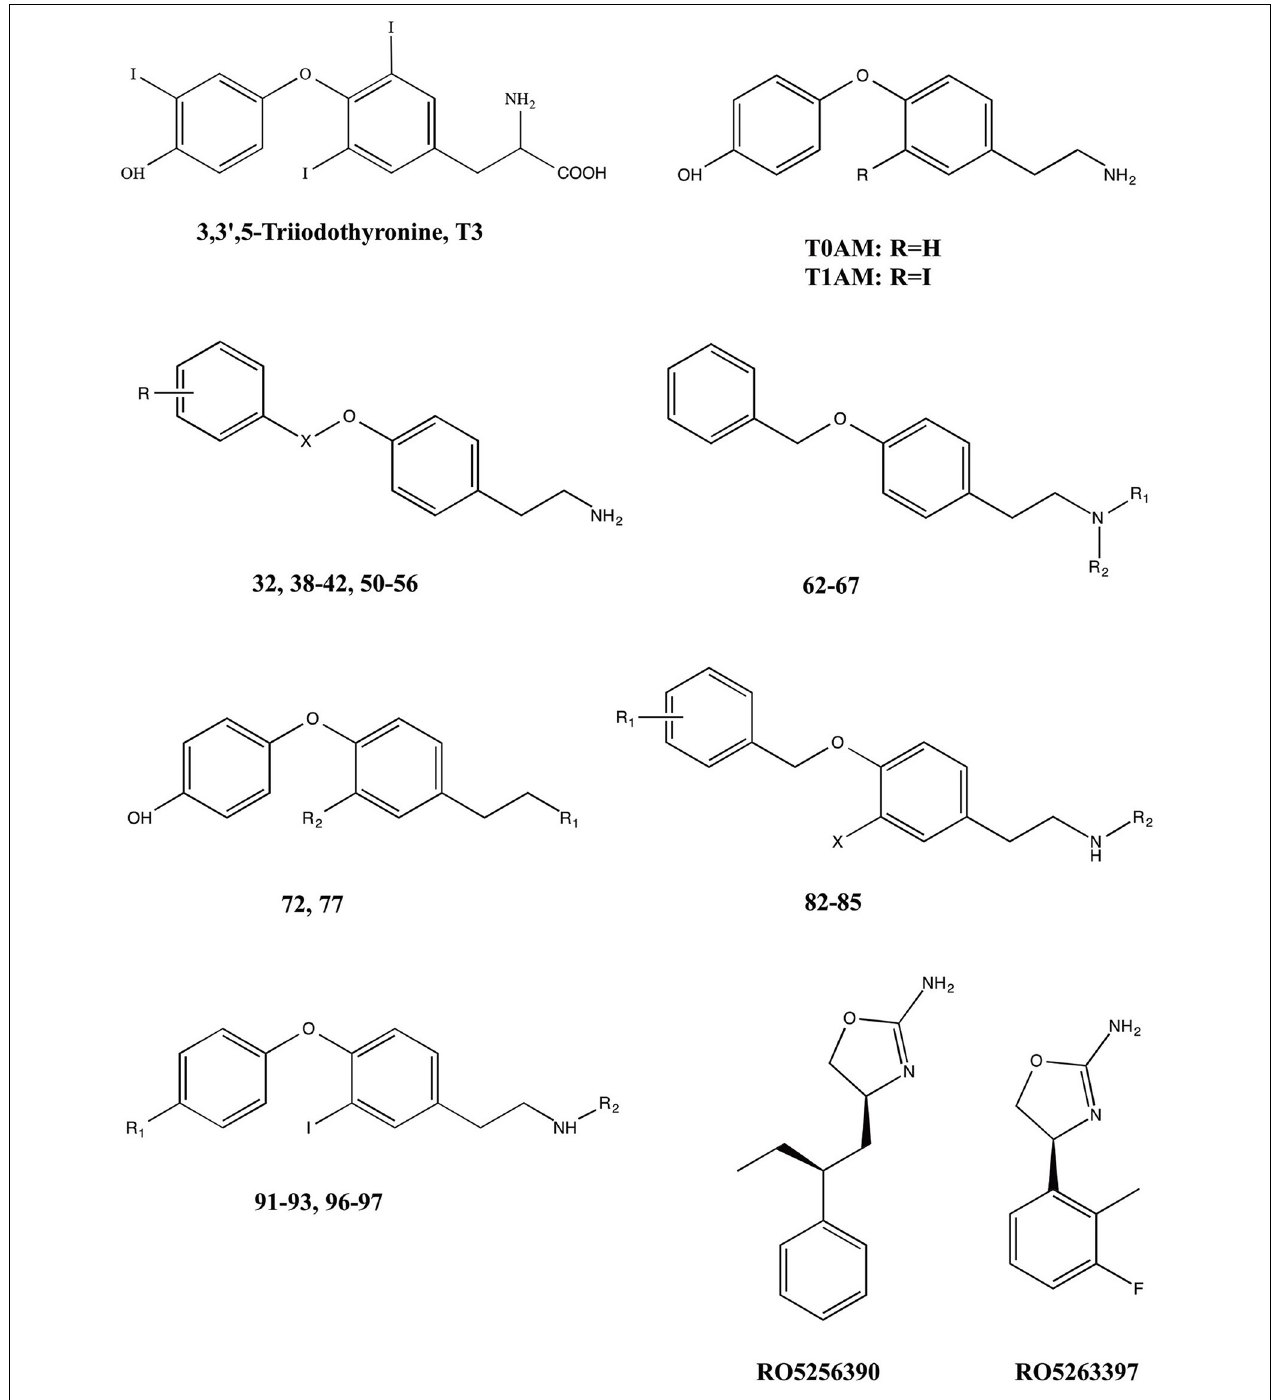
FIGURE 1 | Chemical structures of 3,5,3 (cid:2) -triiodothyronine (T3),endogenous thyronamines (T1AM–T0AM) and synthetic analogs.